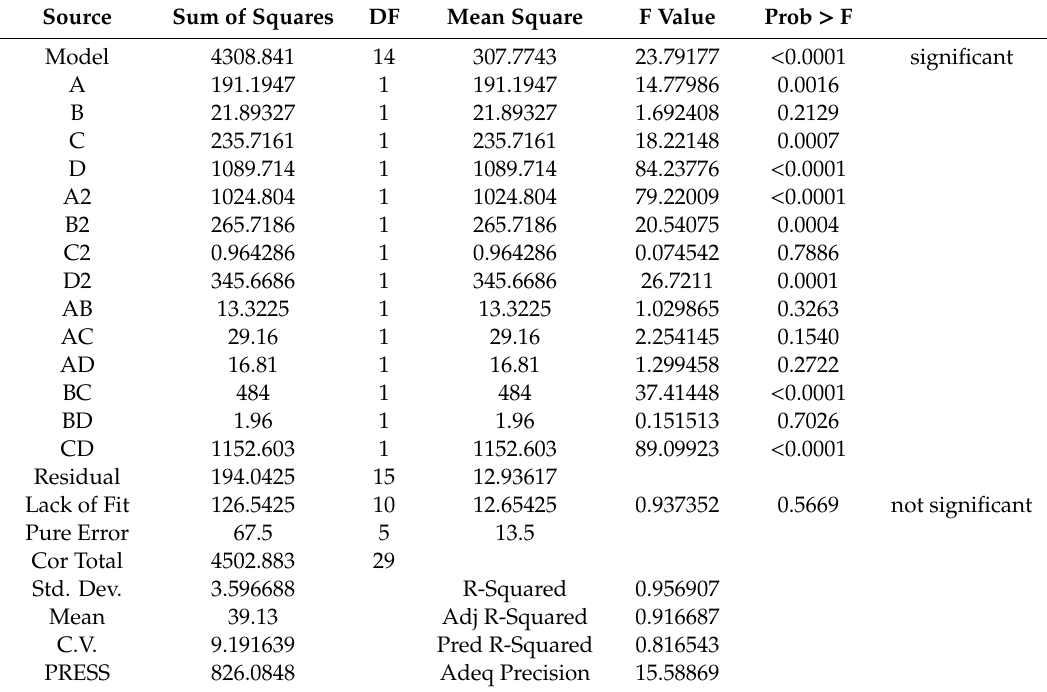
ANOVA analysis of CCD for optimization of keratinase activity by Bacillus sp. strain